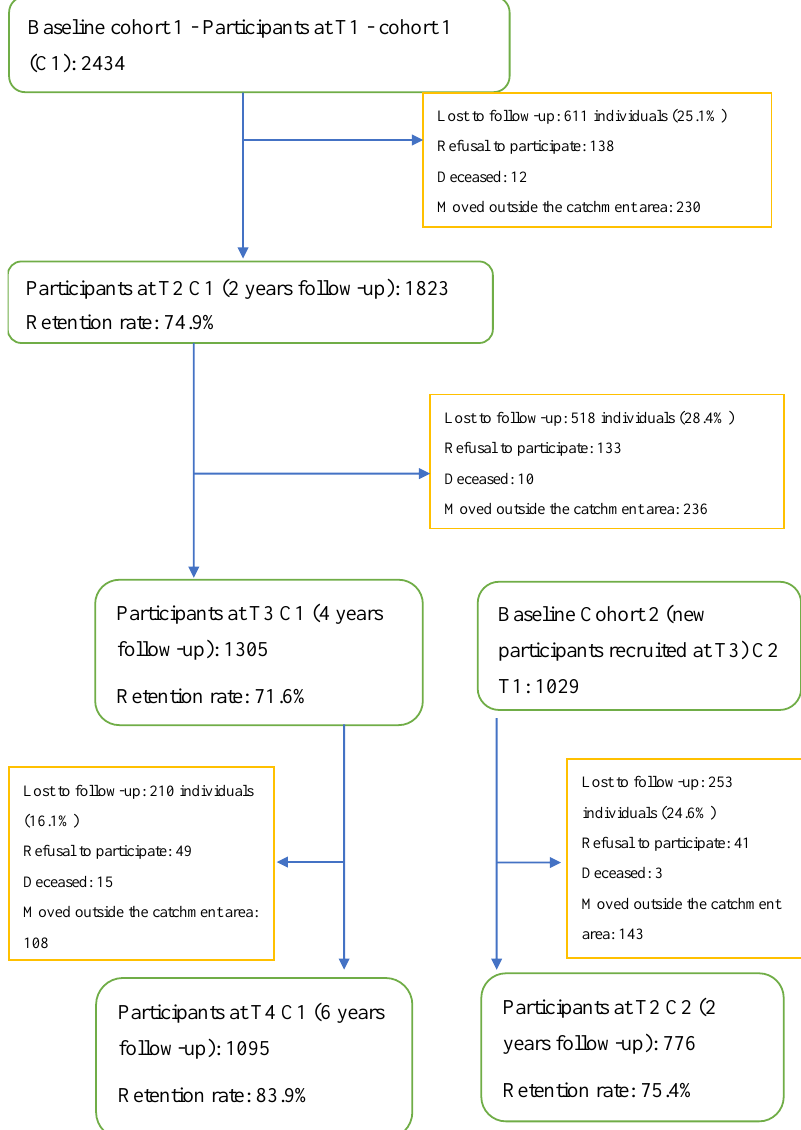
Figure 1. Recruitment flowchart from Time 1 (T1) to T4 data collection periods. Data collection for the present study included: T3 (independent variables) and T4 (dependent variable).